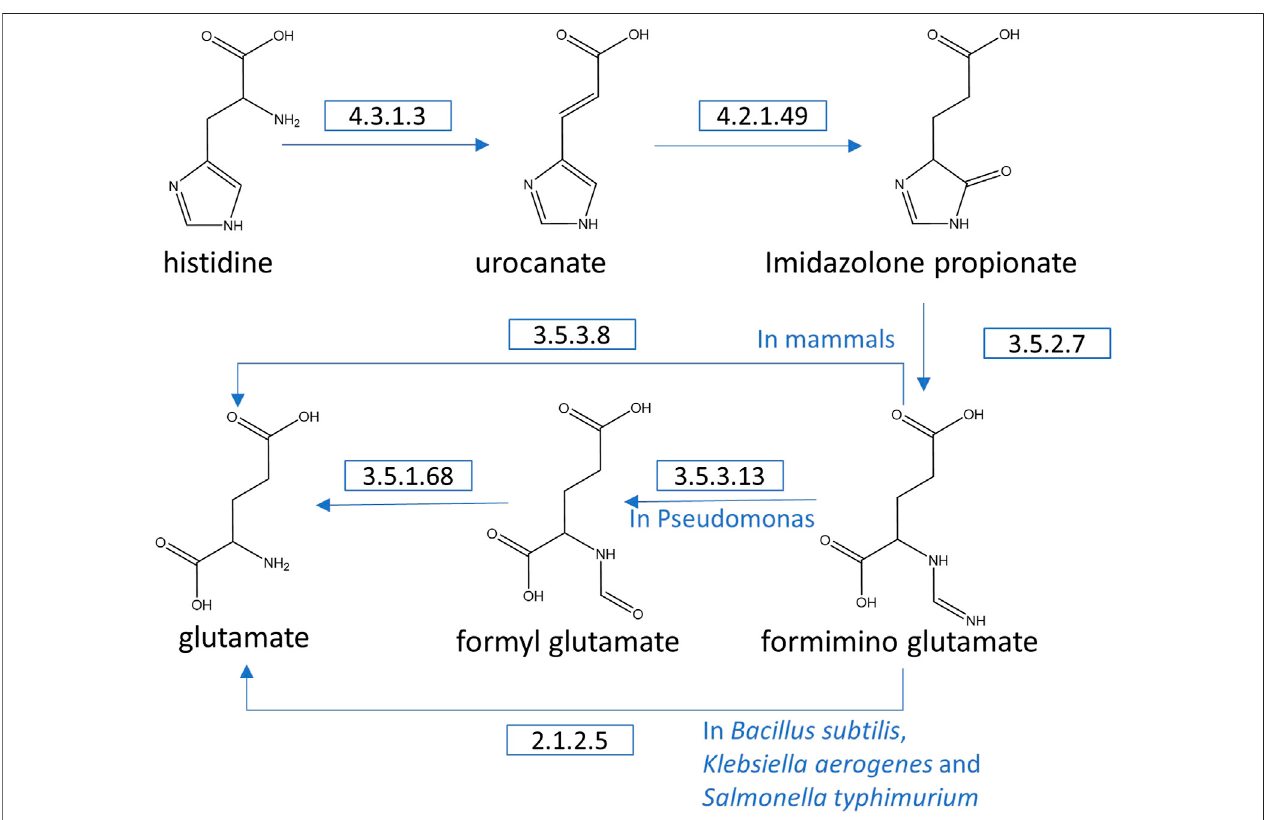
FIGURE 4 | Different histidine degradation pathways. Conversion of histidine to